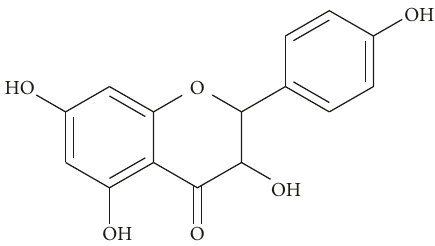
Figure 1: Chemical structure of 3,5,7,4 / -tetrahydroxy-flavanone (1) isolated from P. integerrima